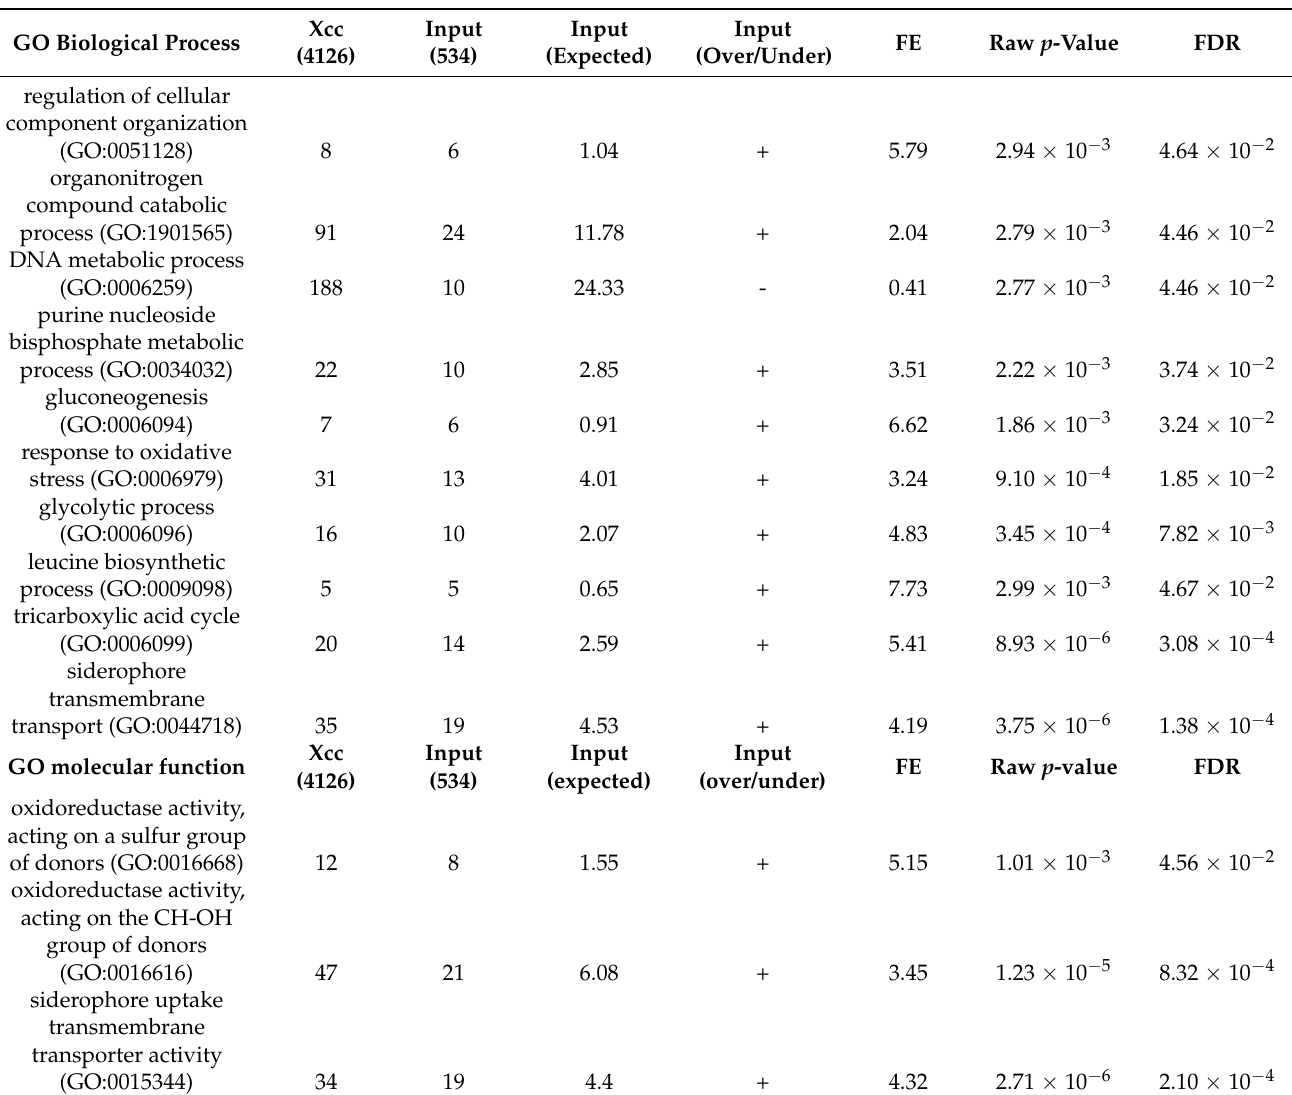
Table 2. GO biological process and molecular function for increased Xaj protein abundance in Xaj CM/WT (FDR ≤ 0.05). FE: fold enrichment. Complete table with GO-terms is available in the supplementary material (Table S4). GO Biological